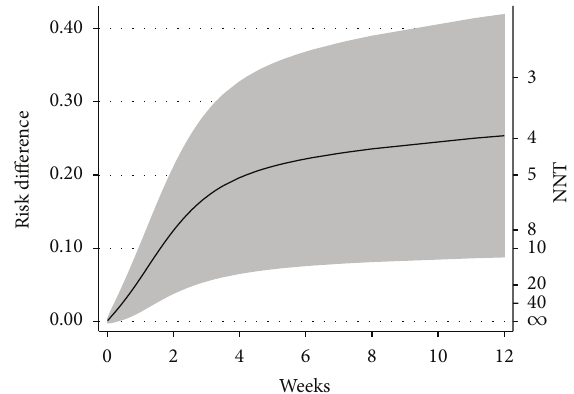
Figure 2: Adjusted risk difference and number needed to treat using flexible parametric survival methods. NNT: number needed to treat.